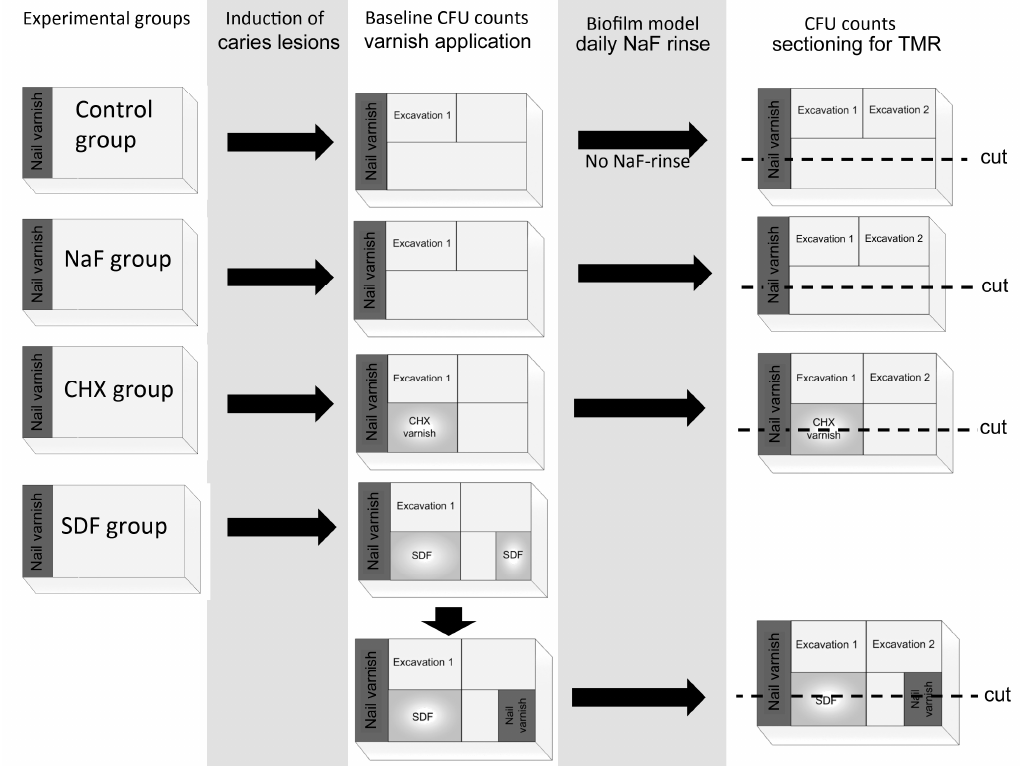
Figure 2. Experimental design for the different test groups. Caries lesions were induced by demineralization for two days and subsequently incubation with LGG. Baseline bacterial counts were obtained from excavated dentin and biofilms and varnishes were applied in the CHX and SDF groups. Cariogenic challenge was created within the biofilm model for six days with additional daily NaF-rinse application in all groups except the control group. CFU counts of carious dentin and demineralization in different areas of the samples was assessed by TMR.